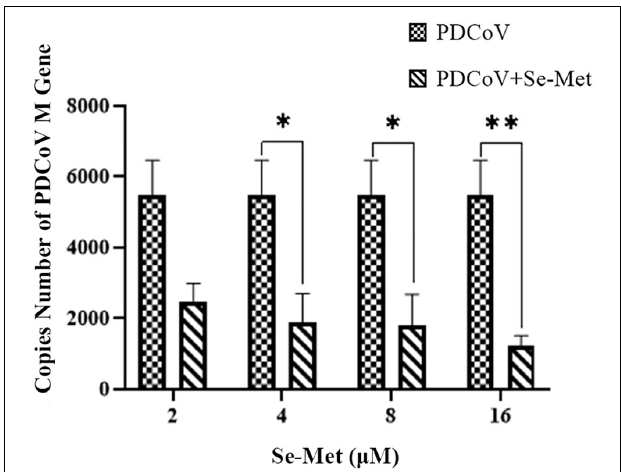
FIGURE 1 | Antiviral effect of Se-Met against PDCoV. LLC-PK cells were incubated with PDCoV for 1 h, and 2, 4, 8, and 16 µ M of Se-Met was added. ∗ 0.01 < P < 0.05, ∗∗ P < 0.01.